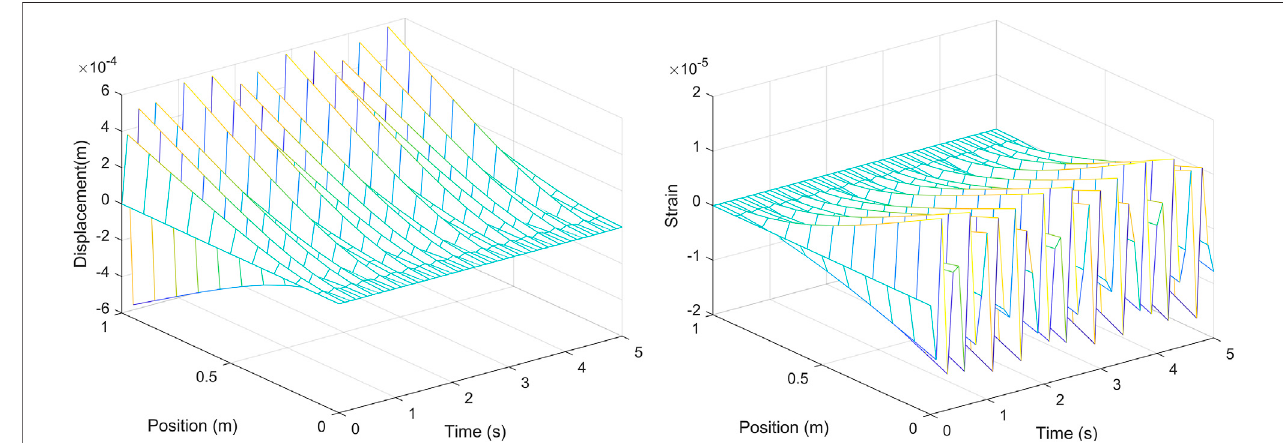
FIGURE 2 | Space – time distribution of displacements and strains of pipe2.